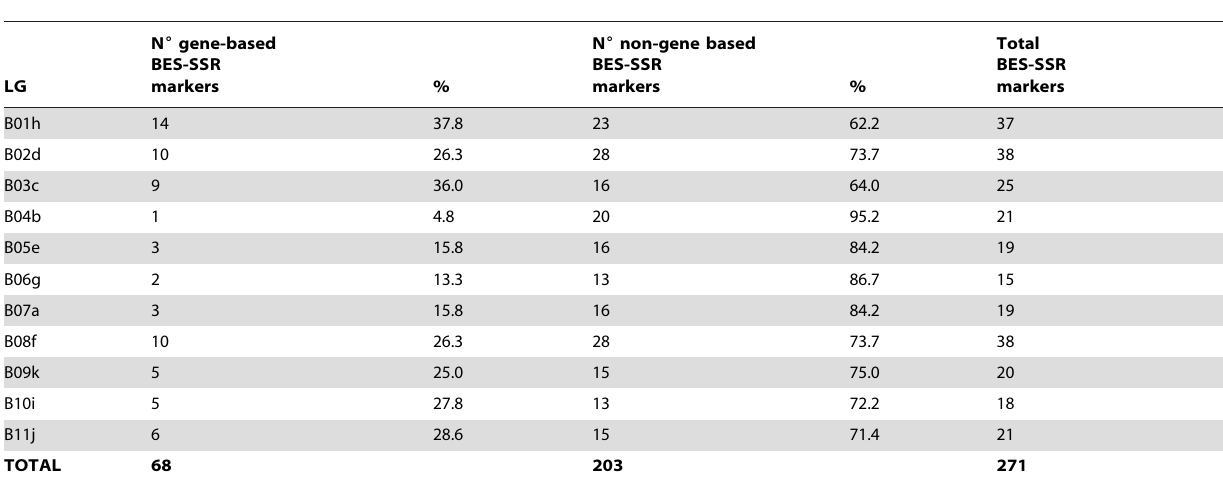
Table 3. Number of genic and non-genic BES-SSR markers mapped in each common bean linkage group.